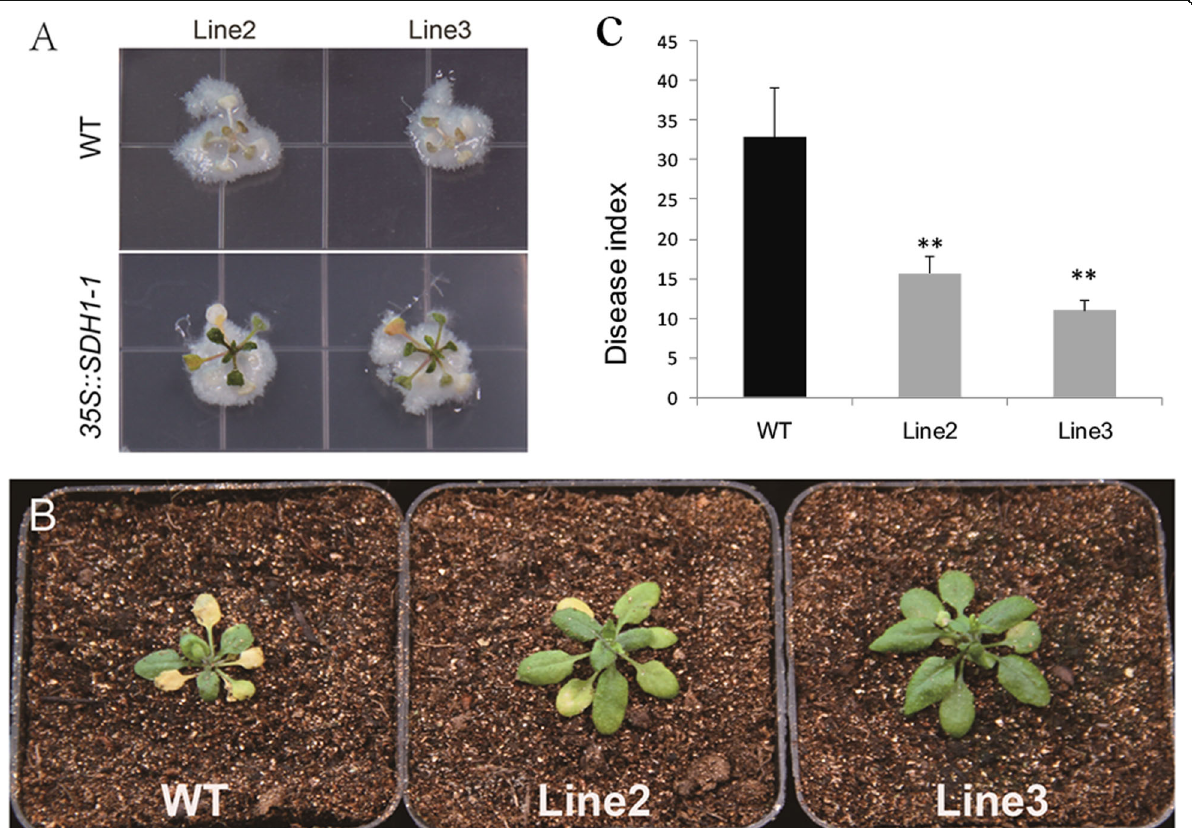
Fig. 5 Effects of overexpression of GhSDH1 – 1 in defense response to V. dahliae in A. thaliana . Selecting Line2 and Line3 which have higher expression levels of GhSDH1 – 1 for testing. Twenty dpi old seedings were inoculated with V. dahliae , the control plants were sprayed with water. Photos were taken at 15 dpi ( a ) and 20 dpi ( b ). c , Assessment of disease index (DI) at 15 dpi. Error bars represent the standard deviation of three